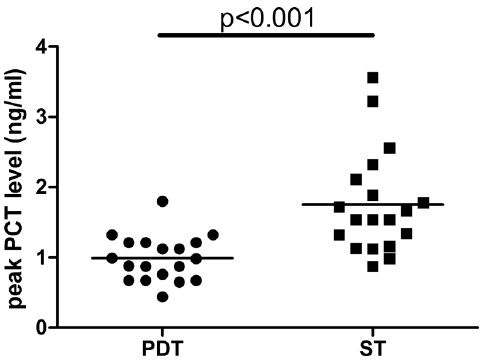
Figure 5 - The peak PCT concentrations in the PDTand ST groups. Data are presented as the mean ± SD. PCT: procalcitonin; PDT: percutaneous dilatational tracheotomy; ST: surgical tracheotomy. Analysis of the student ’ s t test, p o 0.001.